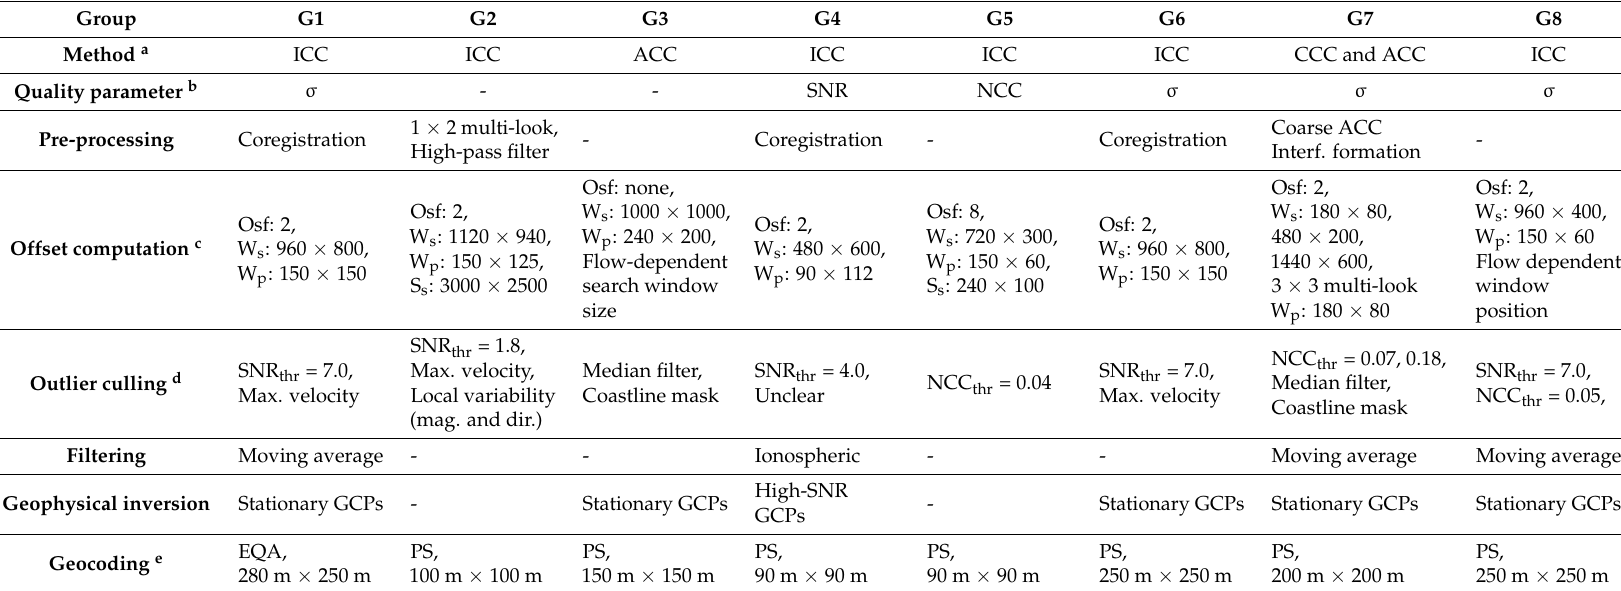
Table 9. Task 4 main processing